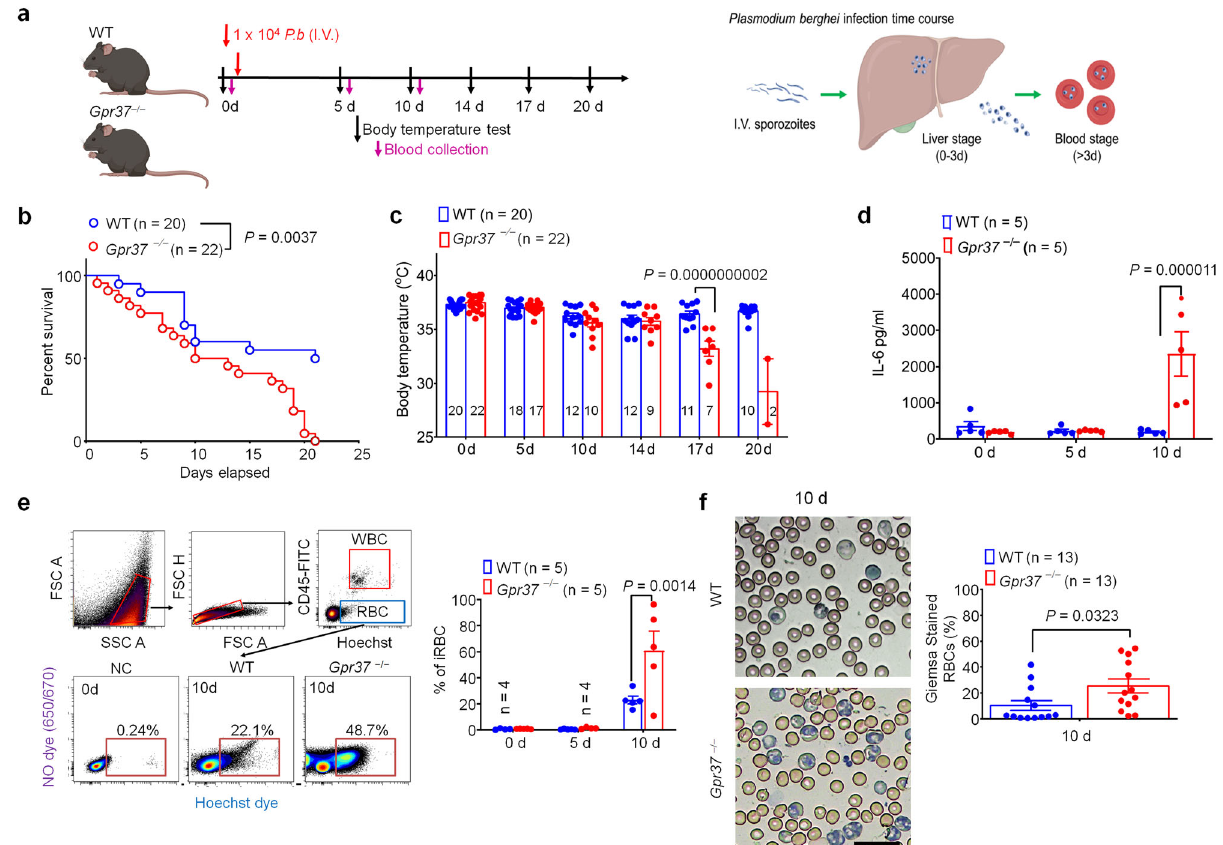
Fig. 2 GPR37 confers protection against malaria infection. a Experimental design for the mouse model of malaria infection. WT and Gpr37 − / − mice were treated with Plasmodium berghei ( P.b .) sporozoites (10 4 , I.V.) and survival, rectal temperature, and serum IL-6 were measured as outcomes of infection. b Survival curves of WT and Gpr37 − / − mice. Sample sizes are indicated in brackets. c Time course of rectal temperature in WT and Gpr37 − / − mice. d Serum IL-6 levels in WT and Gpr37 − / − mice ( n = 5/group). e Flow cytometry analysis of peripheral blood samples collected from WT and Gpr37 − / − mice 10 d after P.b . infection. Infected RBCs (iRBCs) were incubated with Hoechst dye (1 μ g/ml) and CD45-FITC. Left upper panel: gating strategy to remove debris, aggregated cells, CD45 + WBCs, and small particles (<3 μ m). Left down panel: representative images of RBCs sorted from WT or Gpr37 − / − mice 10 d after P.b . inoculation. Right panel: quanti fi cation of fl ow cytometry analysis at the indicated timepoints showing the proportion of iRBCs (Hoechst + RBCs/total RBCs; 1 × 10 6 RBC analyzed per sample, n = 5). f Giemsa staining was performed to detected iRBCs in WT and Gpr37 − / − mice 10 d after P.b infection. Left panel shows representative images. Right panel shows quanti fi cation of Giemsa-stained iRBCs ( n = 13/group). Scale bar, 20 μ m. Data are expressed as mean ± s.e.m. and statistically analyzed by Mantel – Cox test ( b ), 2-way ANOVA followed by Bonferroni ’ s post hoc test ( c – e ), and unpaired two-tailed t -test ( f